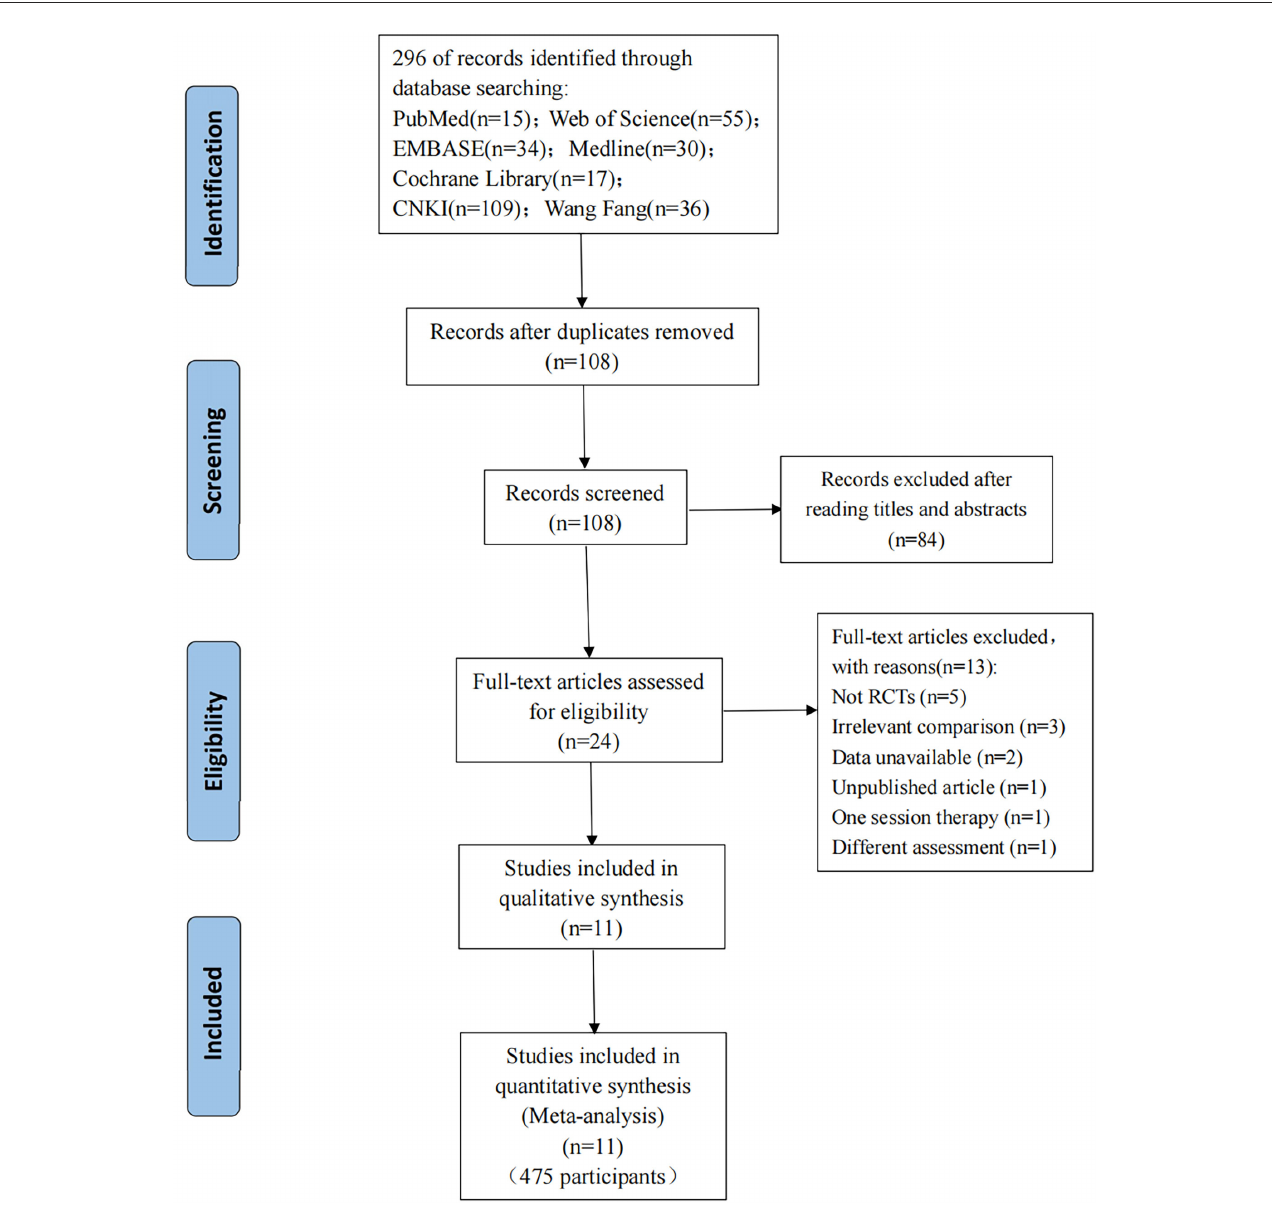
FIGURE1 PRISMA flow diagram presenting the study selection